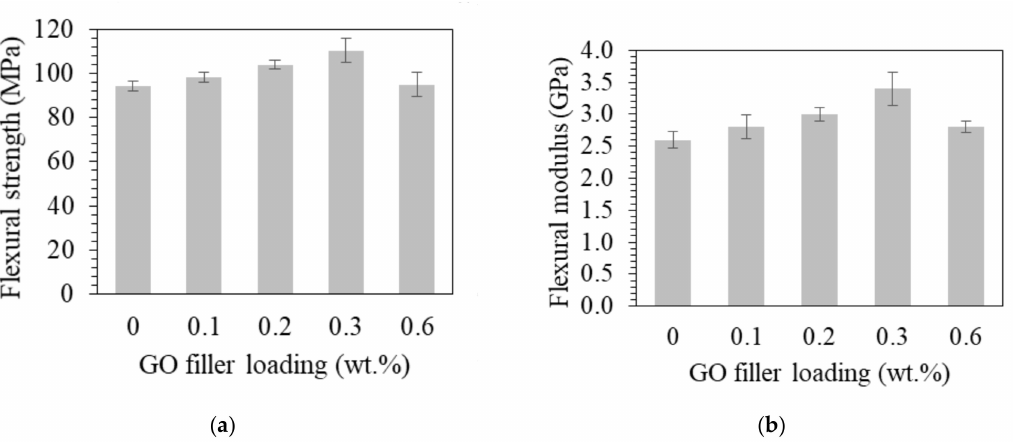
Figure 9. ( a ) Flexural strength and ( b ) flexural modulus results for pure bio-epoxy and bio-epoxy/GO composites containing 0.1–0.6 wt.%